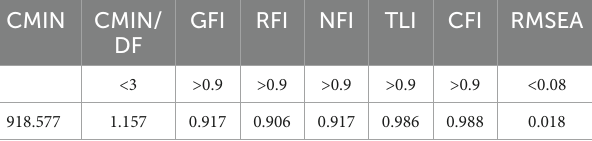
TABLE 5 The measurement model goodness-of-fit